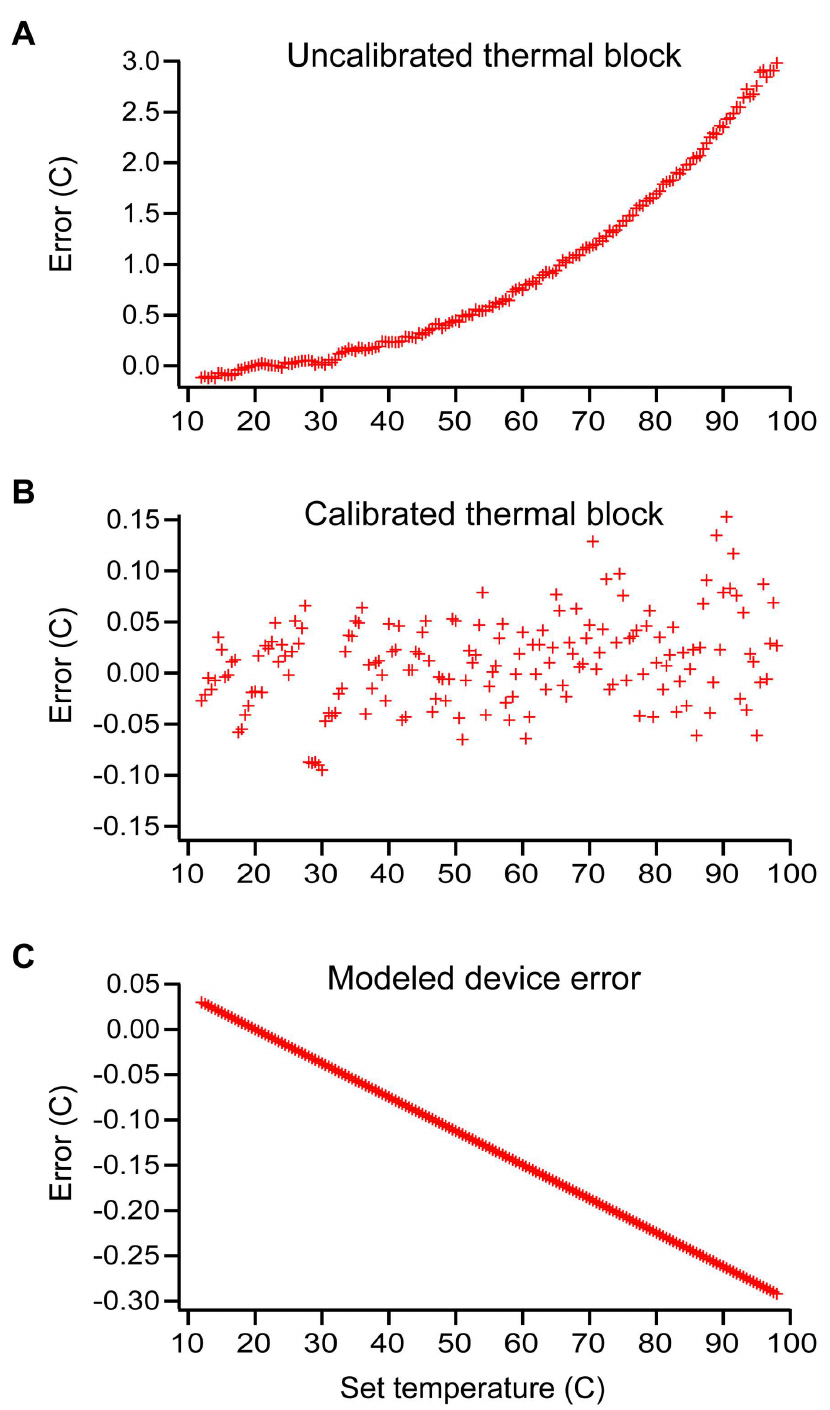
Fig 2. Temperature characterizations of the modified thermal block used in the PTC-200 thermocycler (A–B) and a Comsol-model to determine the on-device error (C). The deviationin the actual and reported temperatures are providedfor the uncalibratedthermal block (A) and for the block after calibration(B). The Comsol-modeleddeviation(C) providesthe differencebetweenthe actual block temperaturesand the theoretical reaction temperatures of the well volumes in a SlipChipmicrofluidicdevice. Error values are the differencebetweenthe thermocycler-reported thermal block temperatureand either the actual thermal block temperatures (measuredby a type K thermocouple) or the modeleddevice temperature; a positive number indicatesthe thermal block temperatureis higherthan the device